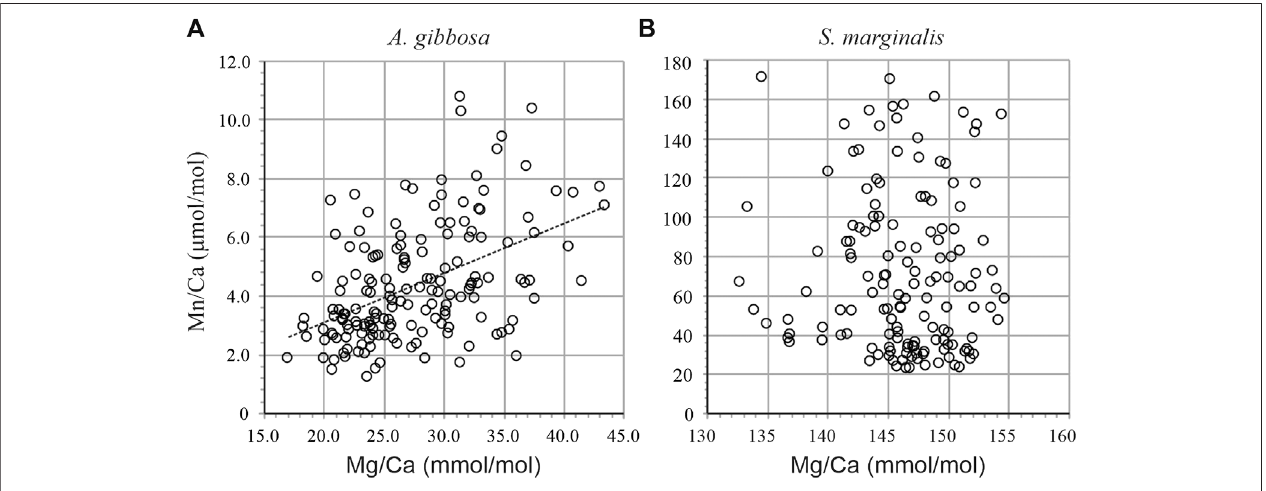
Figure 2 | Mn/Ca vs. Mg/Ca of individual laser ablation measurements for A. gibbosa (A) and S. marginalis (B) . For A. gibbosa , Mn/Ca increases with Mg/Ca following Mn/Ca (cid:1) 0.17 × Mg/Ca-0.23.